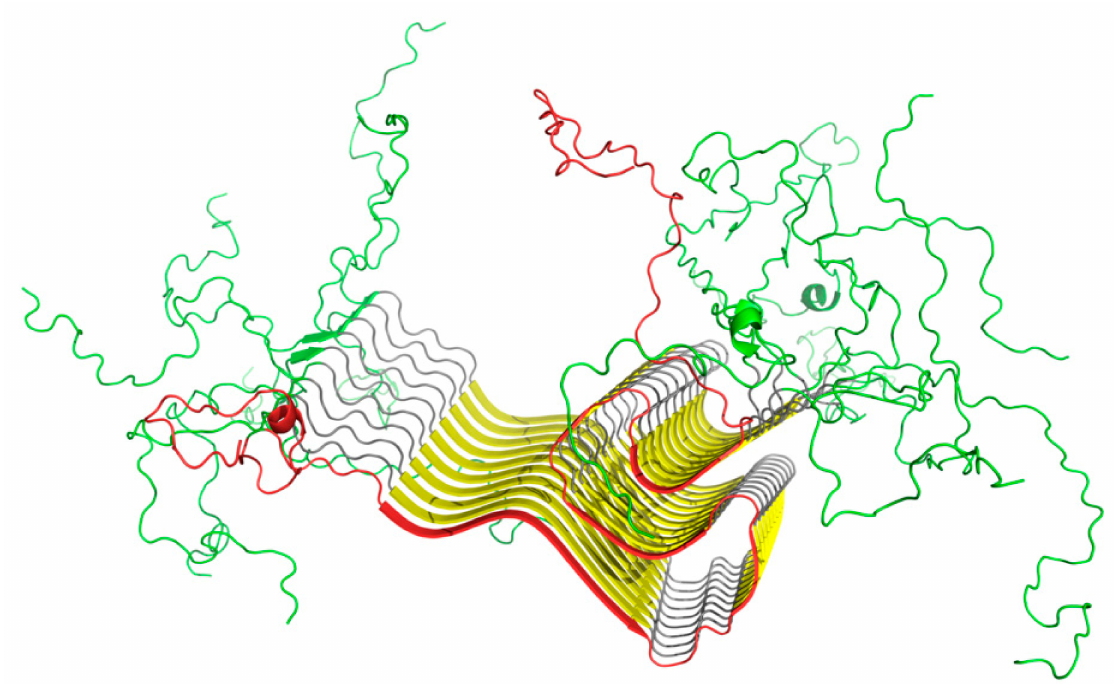
Figure 2. 3D structure of the amyloid form of ASyn, with a clearly distinguished amyloid-like section (30–100). Chain A has been marked red, while random coil fragments (1–29 and 101–140) are shown in